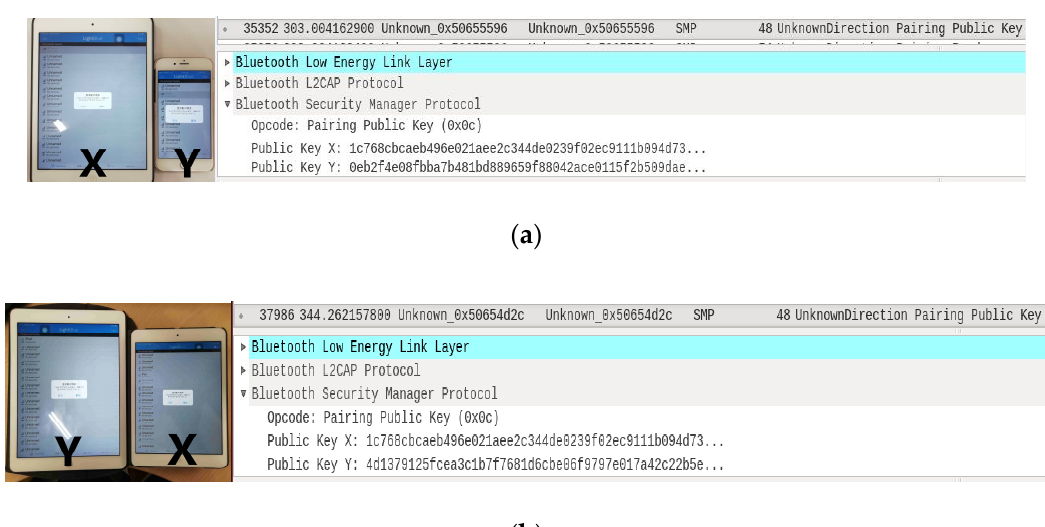
Figure 7. ( a ) Test 1 and its corresponding pairing public key packet (public key X : 1c768cbcaeb496e 021aee2c344de0239f02ec9111b094d7302d017175e50b4a5, public key Y : 0eb2f4e08fbba7b481bd8 89659f 88042ace0115f2b509dae3c8c15510a37d5ba); ( b ) Test 2 and its corresponding pairing public key packet (public key X : 1c768cbcaeb496e021aee2c344de0239f02ec9111b094d7302d017175e50b4a5, public key Y : 4d1379125fcea3c1b7f7681d6cbe06f9797e017a42c22b5e4a30ce5841fb73d6).